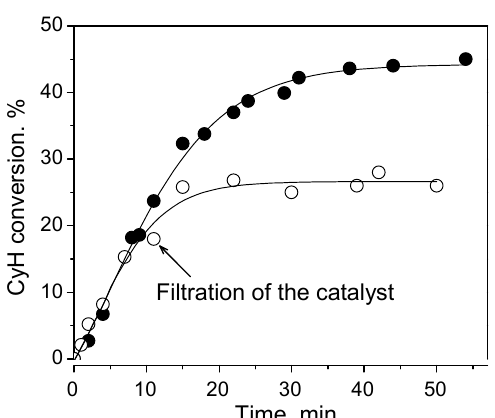
Figure 7. The hot catalyst filtration test for CyH oxidation with H 2 O 2 over MIL-125. Reaction conditions as in Table 1, entry 3.